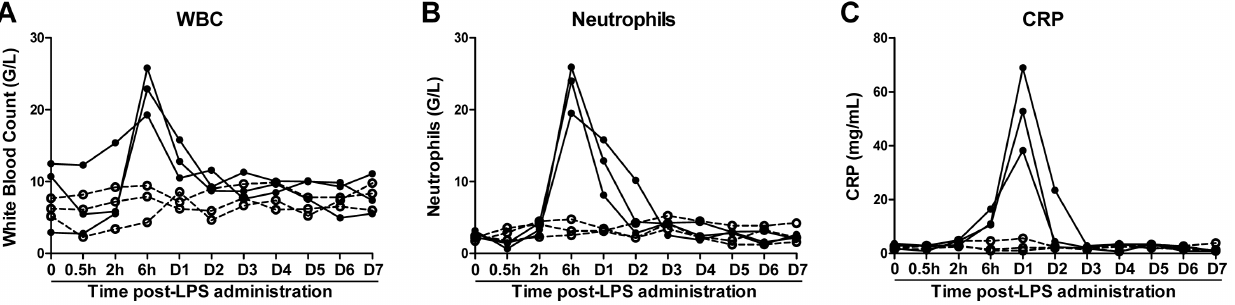
Figure 3. Effect of LPS on WBC, neutrophils and CRP. SIVmac239-infected animals were intravenously injected with either LPS (50 m g/kg; solid circles and lines, n=3) or saline (open circle and dashed lines, n=3) at 45 weeks postinfection. At the indicated time points after LPS administration, white blood cell (WBC) counts (A), neutrophil counts (B), and C Reactive Protein (CRP) levels (C) were determined by a biochemistry analyzer.